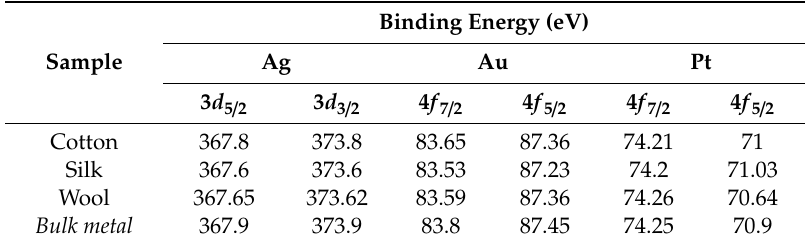
Table 1. XPS peaks of the treated cotton, silk, and wool